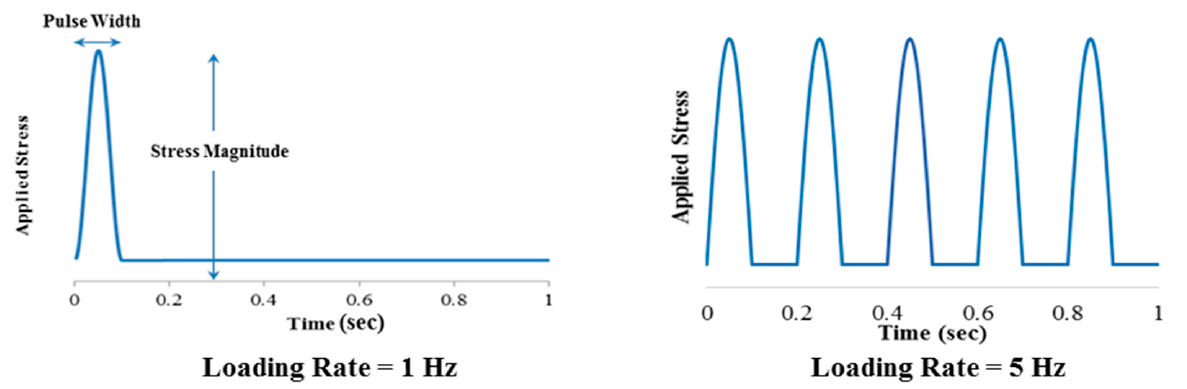
Figure 7. UTM Loading Scheme for Testing the HiSEC Module.